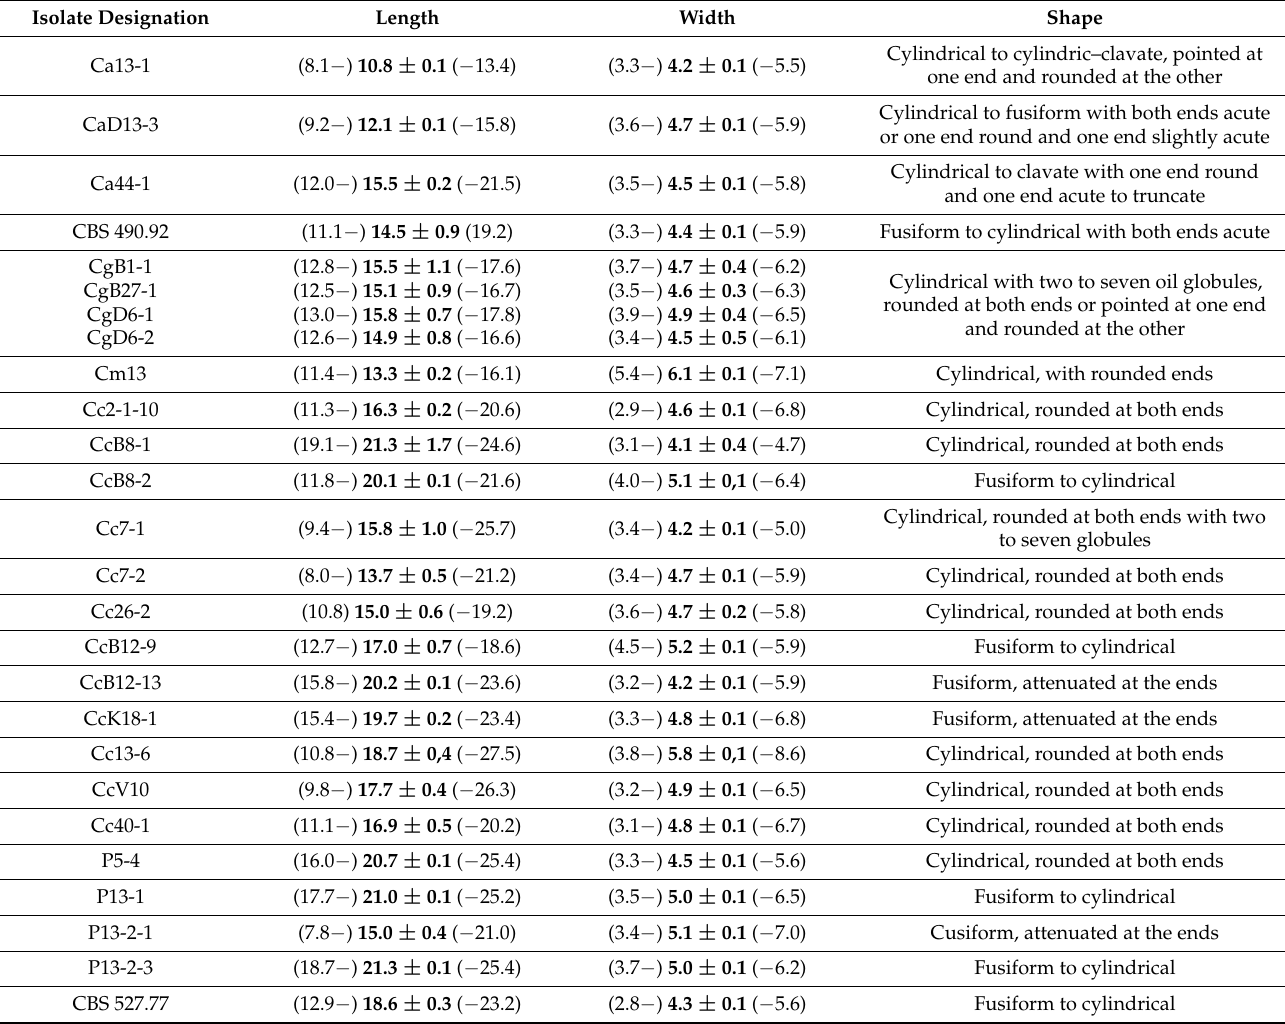
Table 3. Conidial characteristics of the Colletotrichum